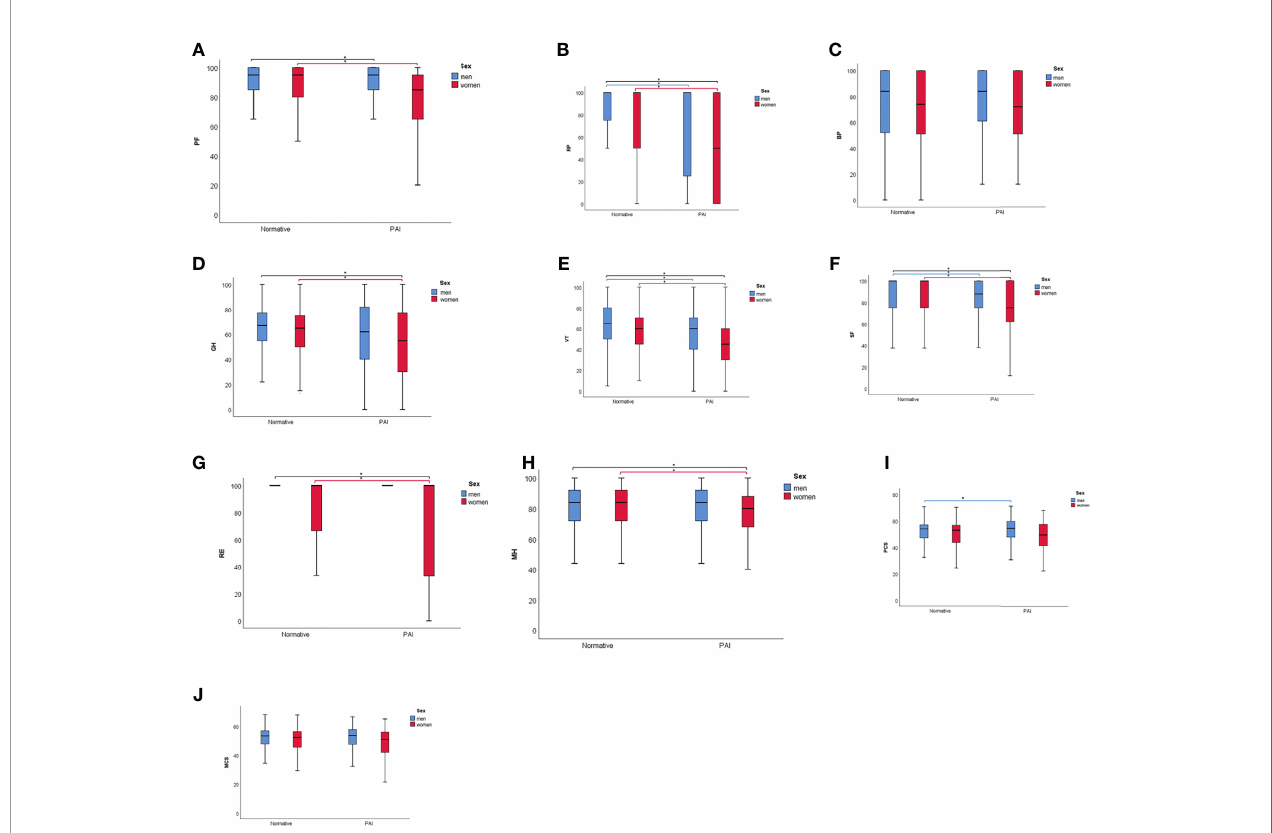
FIGURE 1 | Scores for physical functions (PF) (A) , role physical (RP) (B) , bodily pain (BP) (C) , general health (GH) (D) , vitality (VT) (E) , social function (SF) (F) , role emotional (RE) (G) , mental health (MH) (H) , physical component summary (PCS) (I) , and mental component summary (MCS) (J) in men (blue) and women (red) for normative data and patients with primary adrenal insuf fi ciency (PAI). *p < 0.010.